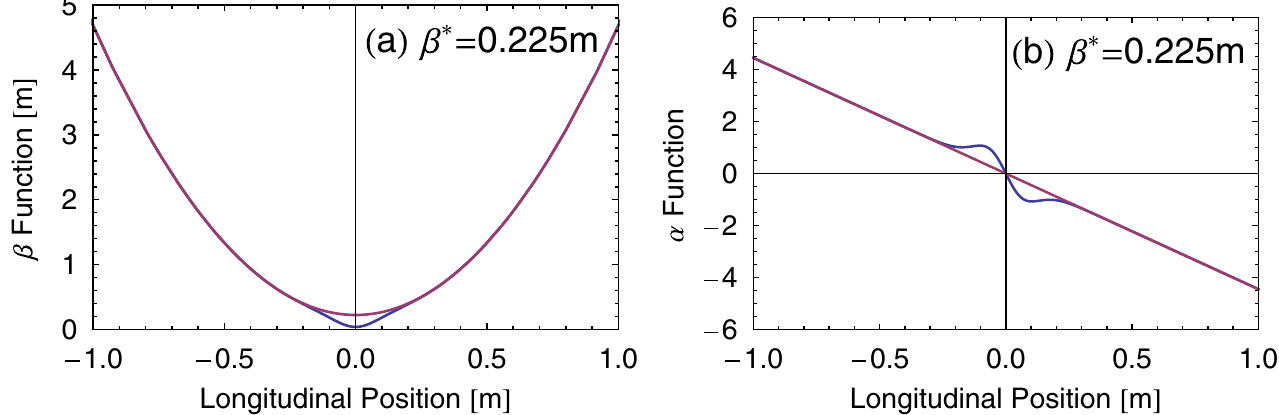
FIG. 2. (Color) The numerical solution of Eqs. (10) is the blue curve, while the red curve corresponds to betatron amplitude function without beam-beam force. In (a) and (b), the initial (cid:6) (cid:5) is 0.225 m, with s (cid:5) ¼ 0 .